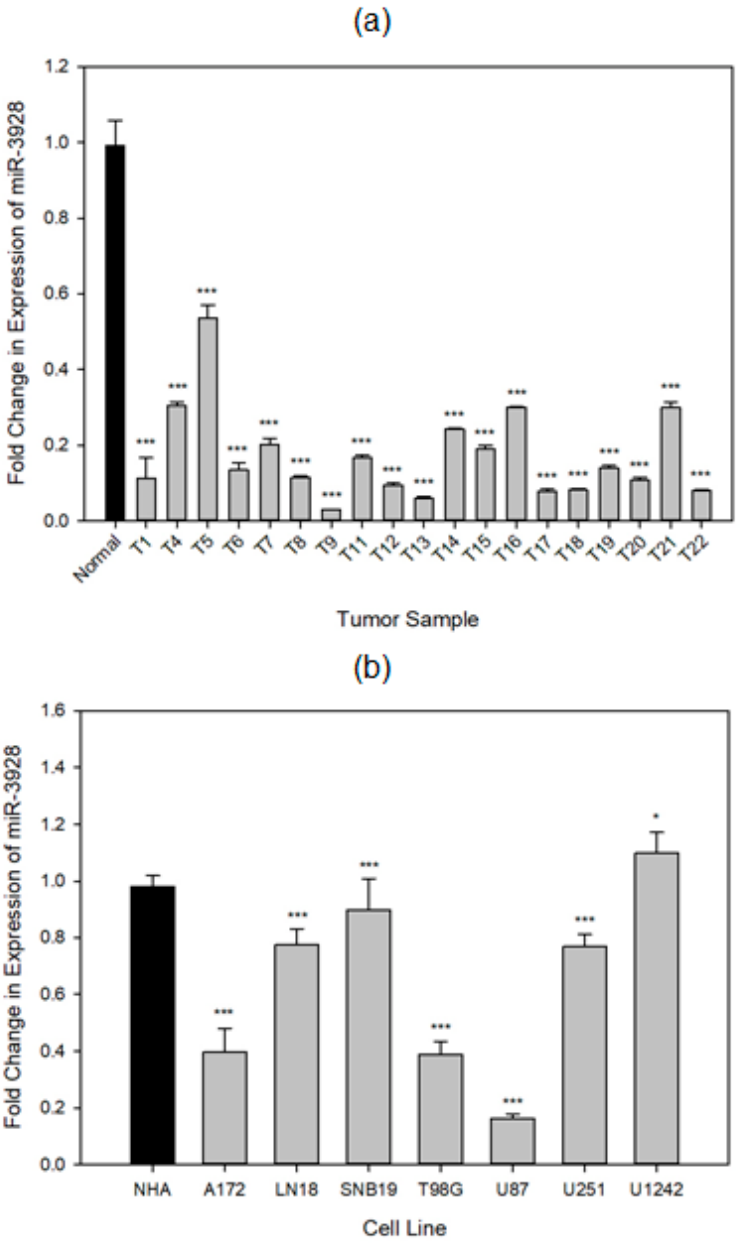
Figure 1. miR-3928 expression is downregulated in GBM tumor and cell lines. ( a ) The endogenous levels of miR-3928 were measured with RT-qPCR in a panel of GBM patient tissue samples. The values for each tissue sample are normalized to normal brain cerebral cortex and the housekeeping gene, RNU6B, U6B small nuclear RNA gene. miR-3928 was considered deregulated when the differences in mean expression was determined to be statistically significant ( p < 0.05). The endogenous levels of miR-3928 are downregulated in all measured GBM tissue samples. ( b ) The endogenous levels of miR-3928 are measured through RT-qPCR in 7 commonly used GBM cell lines. The values are normalized to normal human astrocytes (NHA) and U6B. The endogenous levels of miR-3928 are downregulated in 6 of 7 GBM cell lines. All RT-qPCR samples were subsequently analyzed on an agarose gel to confirm binding specificity. Student’s t -tests have been performed to compare the qPCR cycle numbers. * = p ≤ 0.05, *** = p ≤ 0.001.